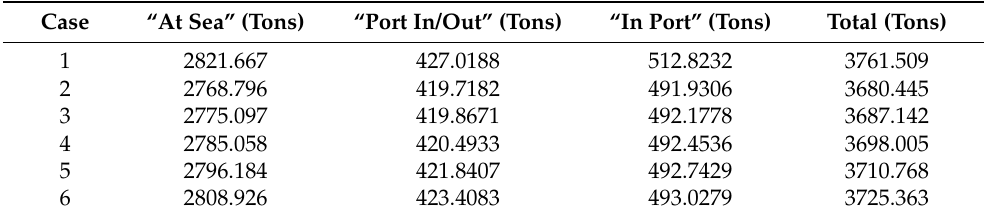
Table 5. Generators’ fuel consumption in each case.